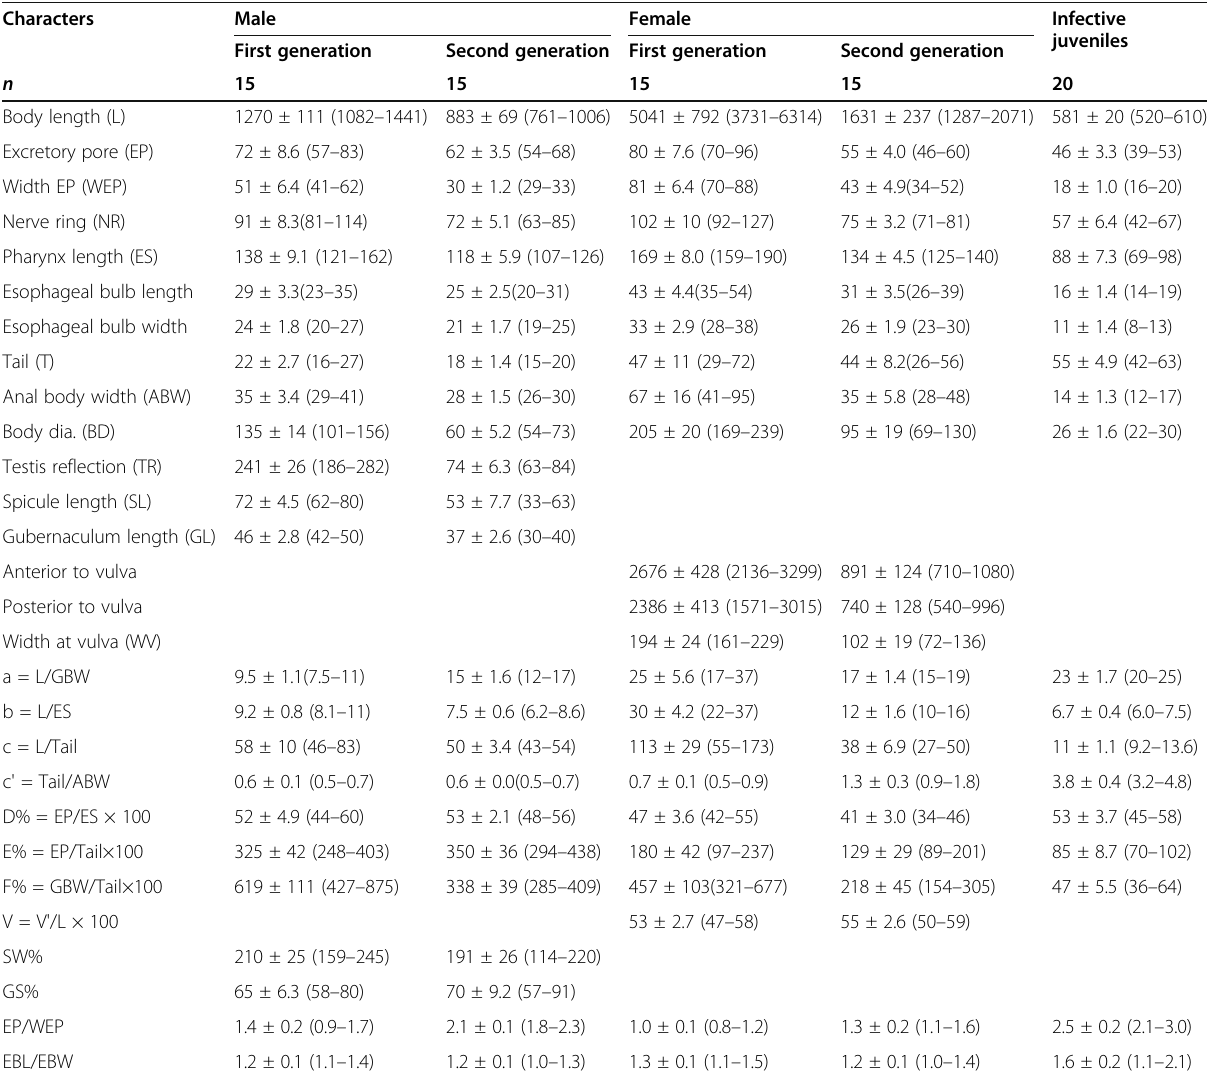
Table 1 Morphometrics of all generations of Steinernema abbasi CS38. All measurements are in μ m (except n , ratio and percentage) and in ± SD